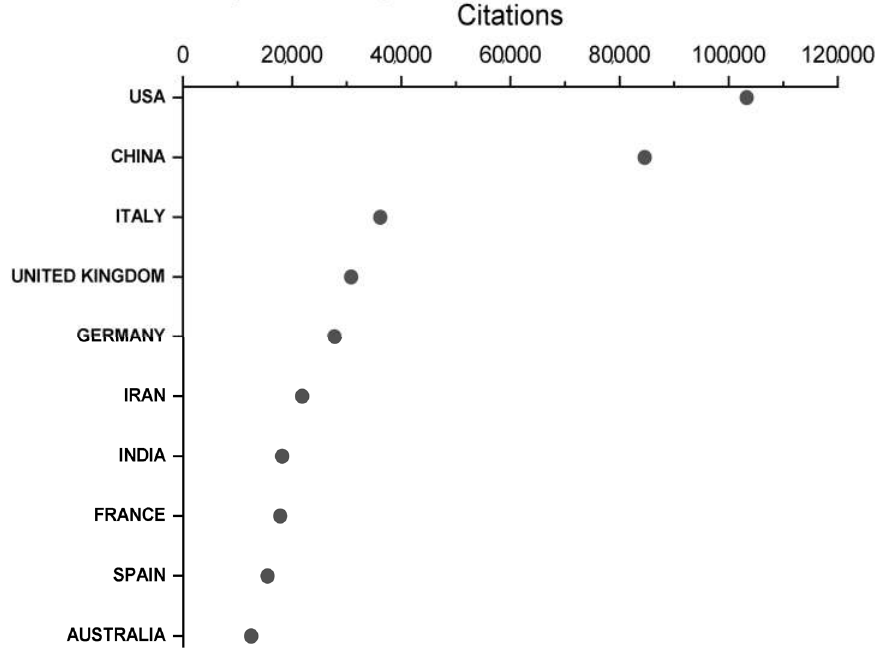
Figure 16. Number of articles over time according to country of origin.